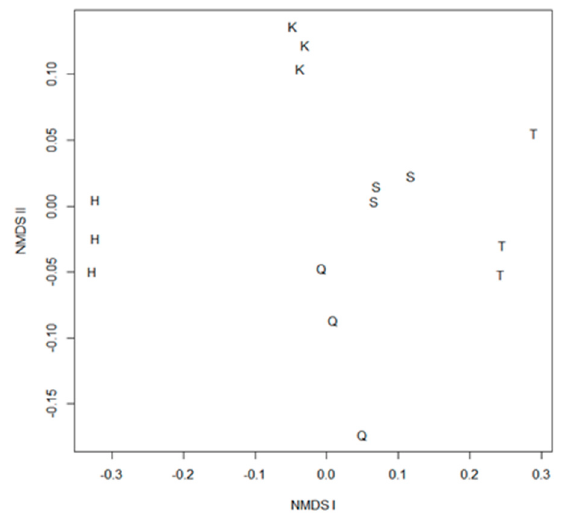
Figure 5. NMDS plot showing both spatial variation among five stations and measurement errors for each station based on the relative abundance of 16S and 18S sequencing barcoding at the genus level. Station codes represented the first letter of their names: Q: Qushou, K: Kuxin, S: Songgan, H: Heijizuo, T: Taizishang. Three identical letters represent three repetitions of each station. There were three repetitions for each sample.